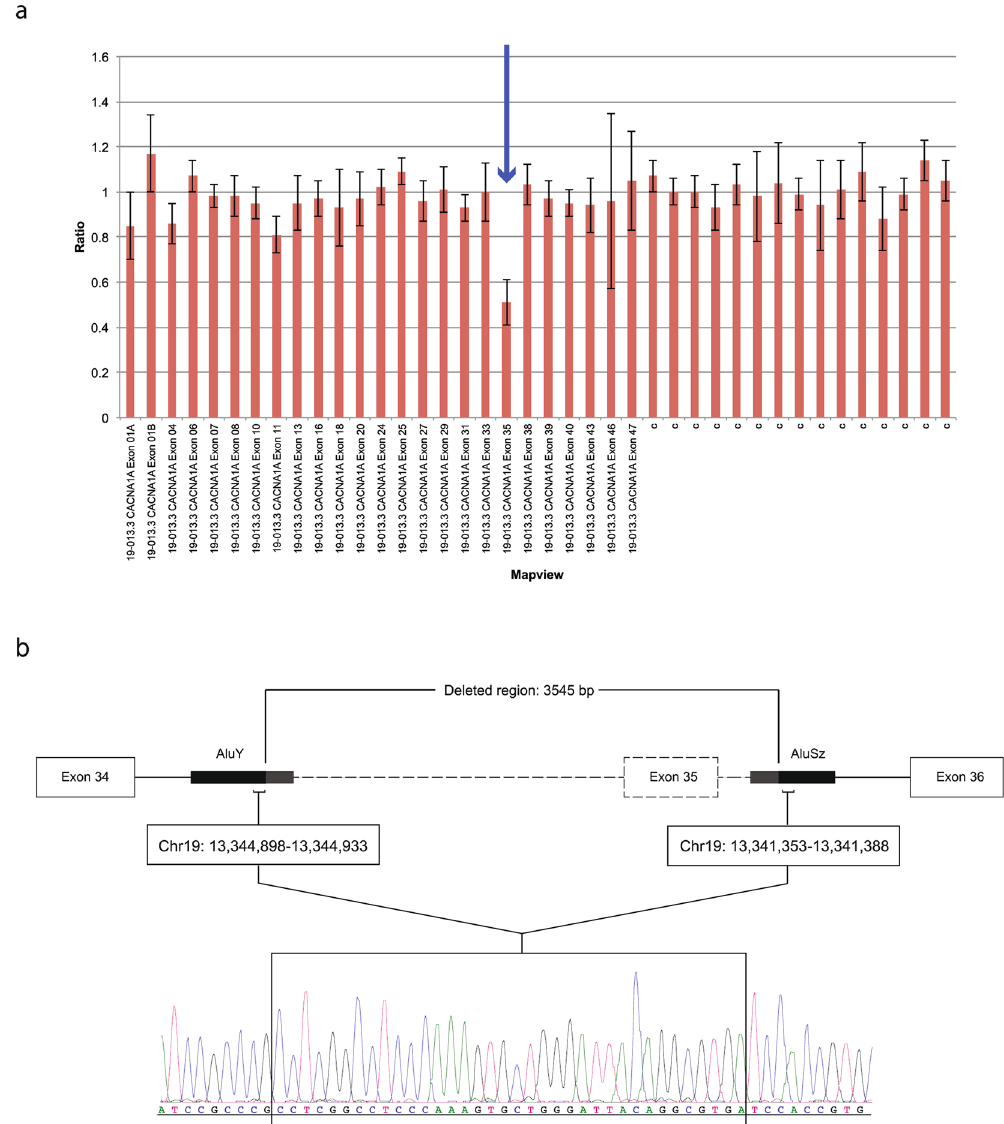
Figure 3. CNV studies in the CACNA1A gene of patient 474. ( a ) Results from the MLPA analysis performed with Coffalyser. The deleted exon 35 is indicated with an arrow. C: control probe. ( b ) Deletion breakpoint mapping. Sequence chromatogram corresponding to the homologous fragment from AluY and AluSz sequences. The identical shared sequence by the 5 ′ and 3 ′ Alu elements located in introns 34 and 35 that mediated the recombination is framed. Location of fragments taken from UCSC Genome Browser on Human Feb. 2009 Assembly